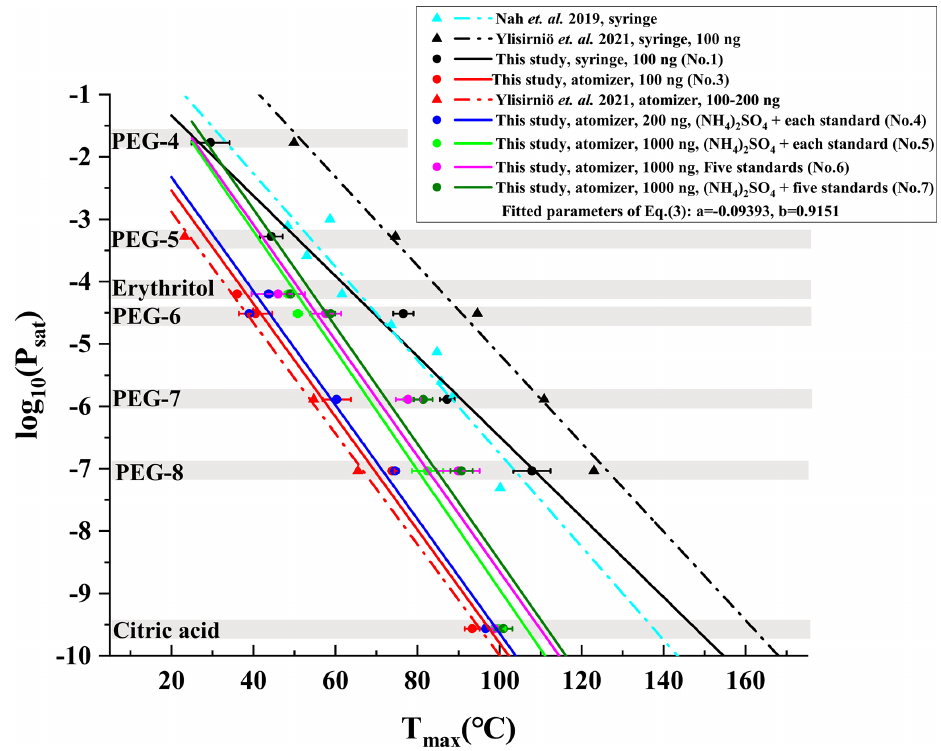
Figure 1. Comparison of calibration results obtained in this study with those reported previously. These solid lines denote the calibration results obtained in this study. Error bars represent ± 1 standard deviation of T max from four replicate experiments. The fitted parameters correspond to the dark green line. The dashed–dotted light blue line denotes calibration results obtained with acids and erythritol by Nah et al. (2019) using the syringe method. The dashed–dotted black line represents calibration results obtained with 100ng deposited PEGs (including PEG-4, PEG-5, PEG-6, PEG-7, and PEG-8) by Ylisirniö et al. (2021) using the syringe method. The dashed–dotted red line denotes calibration results obtained with 100–200ng PEGs (including PEG-5, PEG-6, PEG-7, and PEG-8) by Ylisirniö et al. (2021) using the atomization